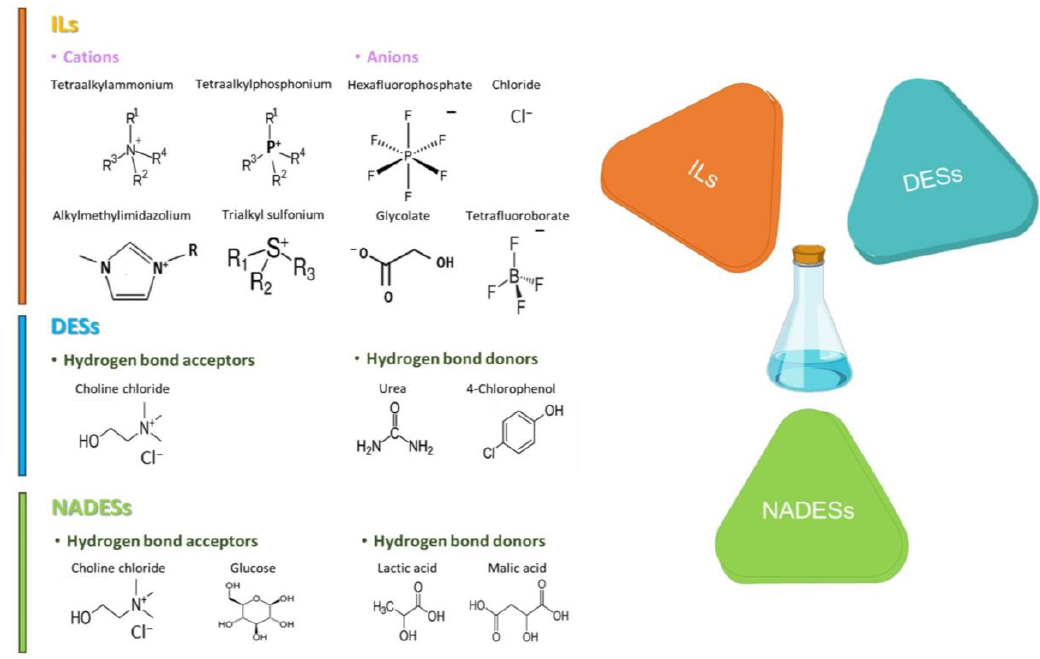
Figure 7. Most common components of ILs, DESs and NADESs [122].